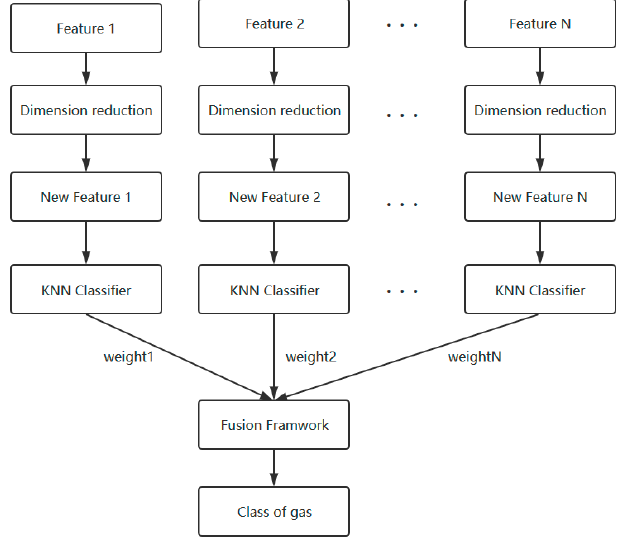
Figure 1. The flow chart of the feature selection and fusion framework.